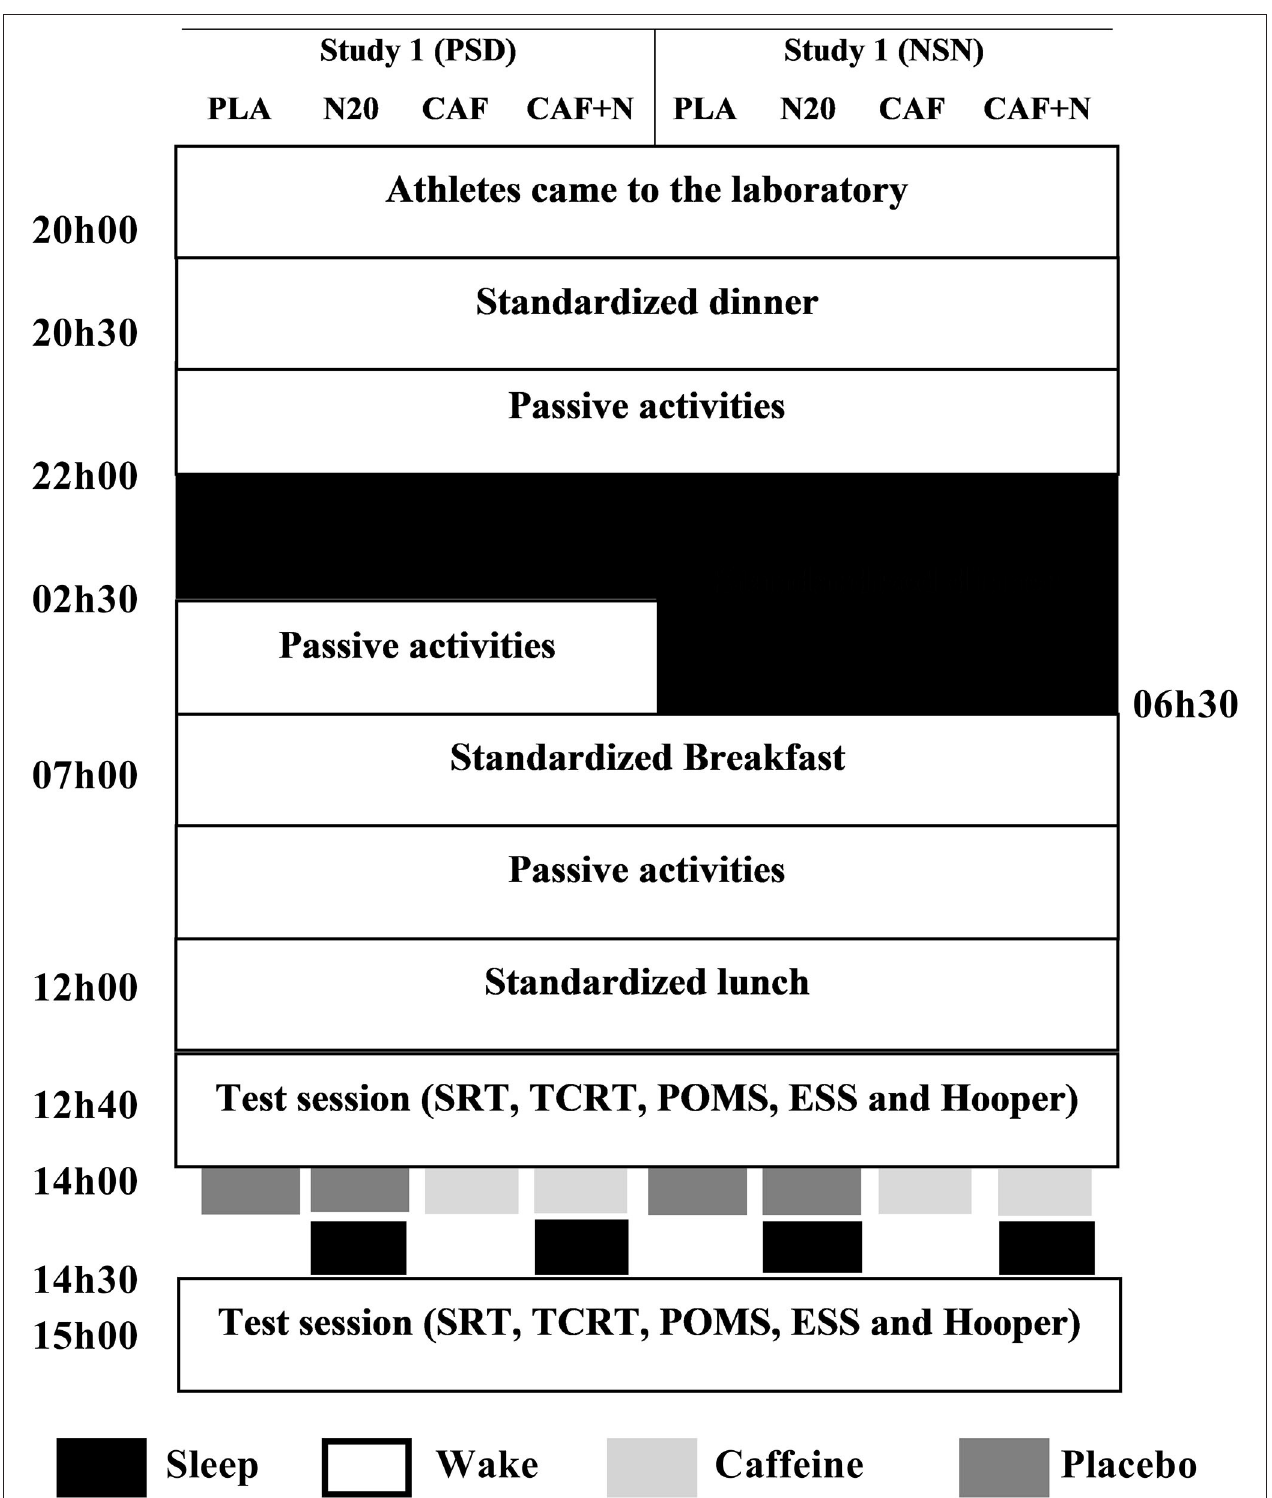
FIGURE 1 | Simplified experimental protocol of the two studies. In the first study (left panel), all sessions were performed after partial sleep deprivation (PSD). In study 2 (right panel), all test sessions were performed after a night of normal sleep (NSN). PLA, placebo ingestion, N20, 20min nap opportunity with placebo session,